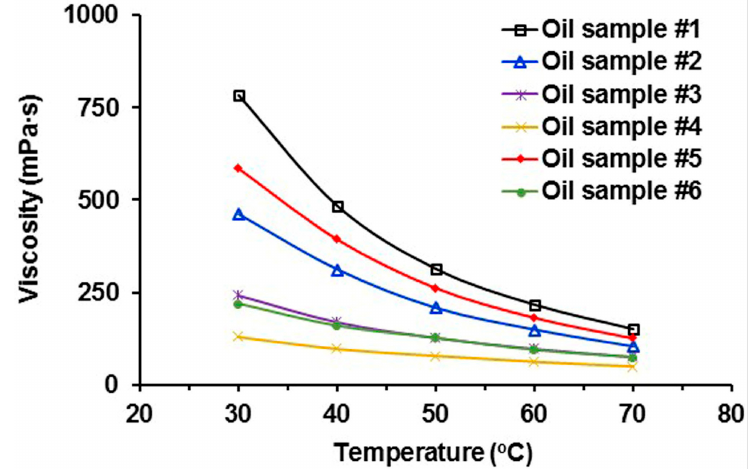
Figure 6. Viscosity-temperature curves of heavy oil samples.